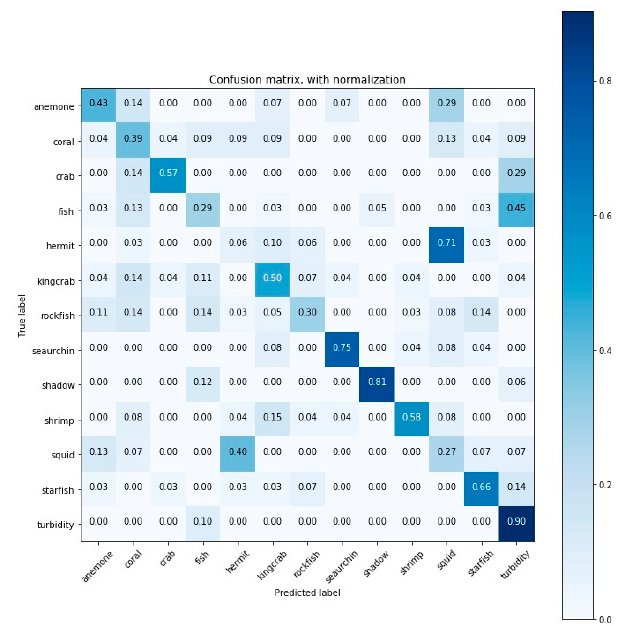
Figure A1. Confusion matrix for the classification results (accuracy) obtained by linear support vector machine (SVM).